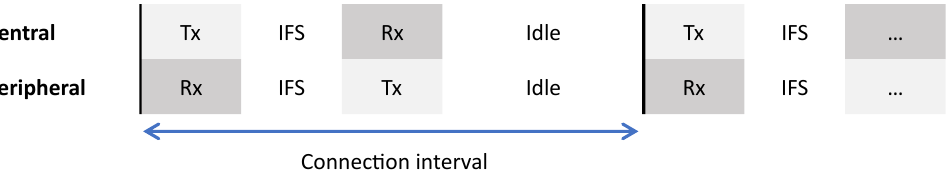
Figure 1. Packet